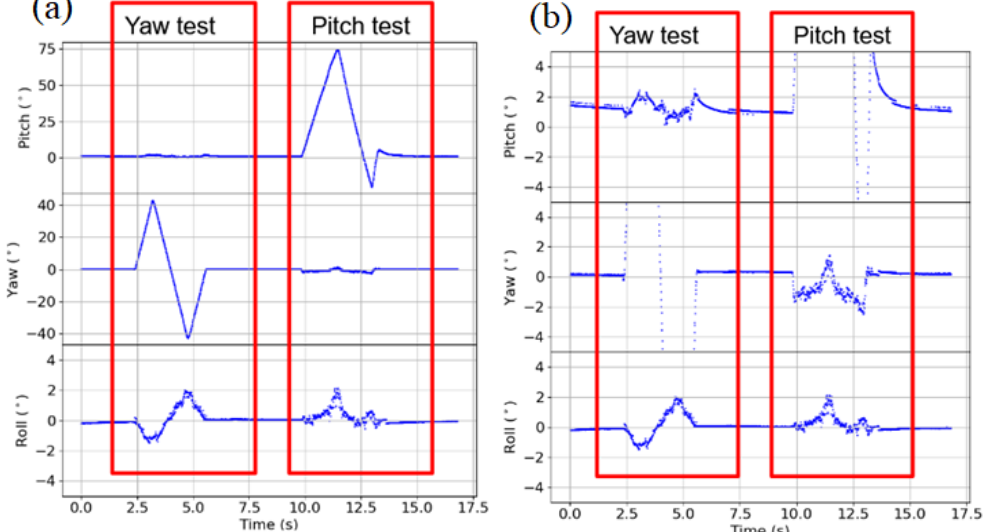
Figure 17. Gimbal axis coupling quantification tests. ( a ) Normal view. ( b ) Zoomed-in view.